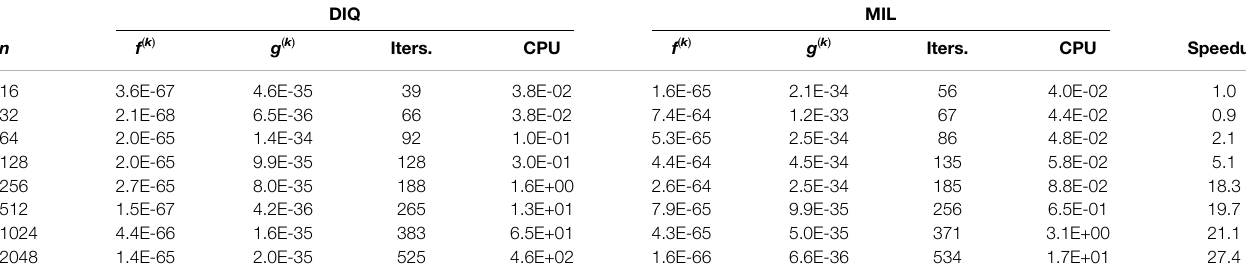
TABLE 5 | Performance comparison of DIQ vs. MIL methods testing on Sphere function. DIQ